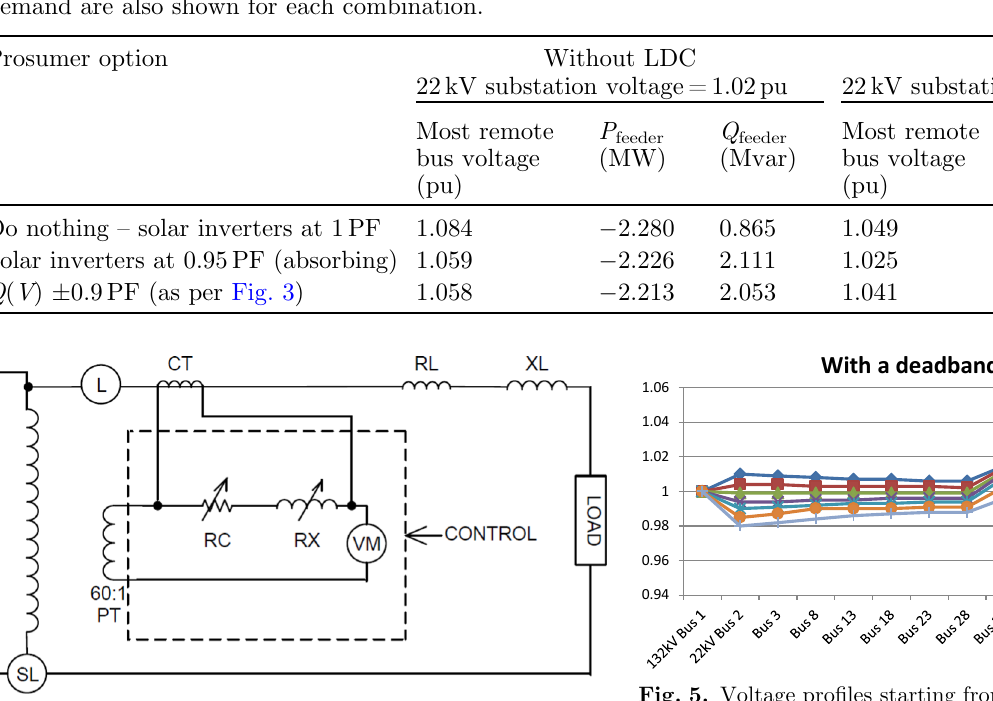
Fig. 4. Line drop compensation diagram adapted from Cooper Power Systems [11].